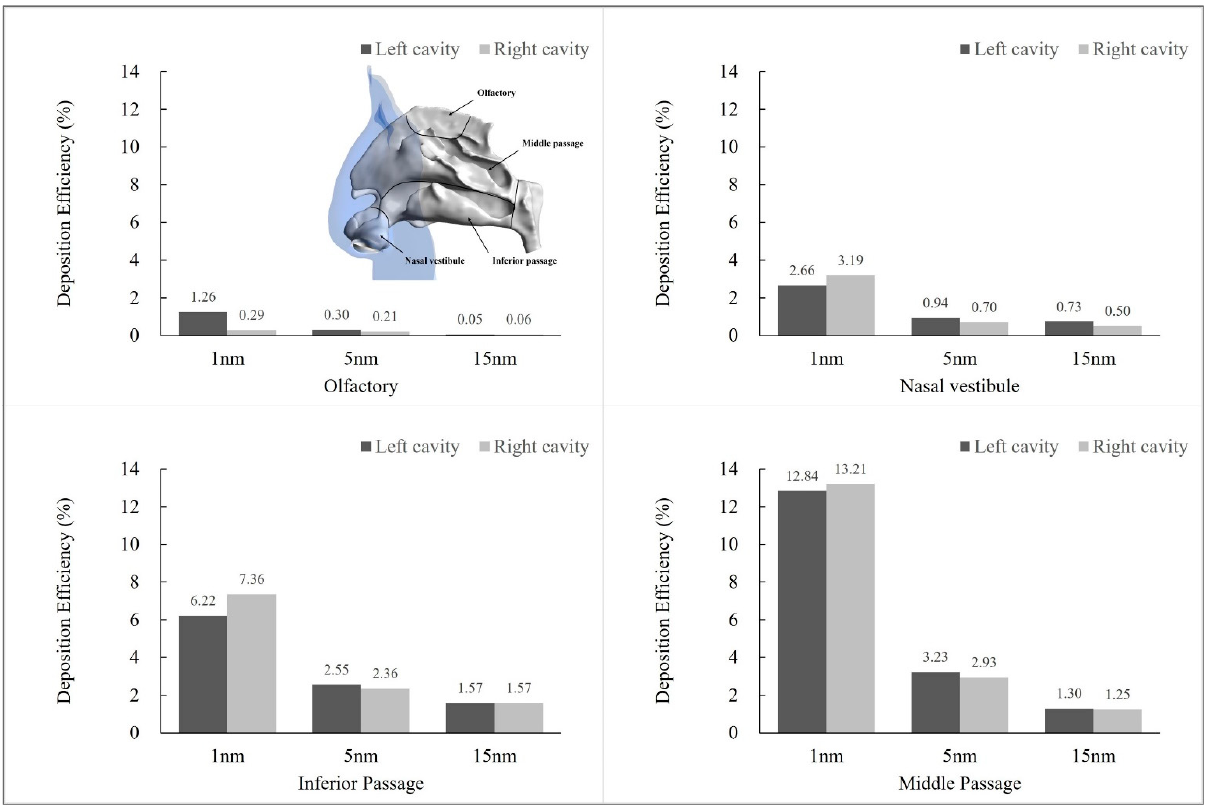
Figure 13. Comparison of the regional deposition efficiencies for 1, 5, and 15 nm